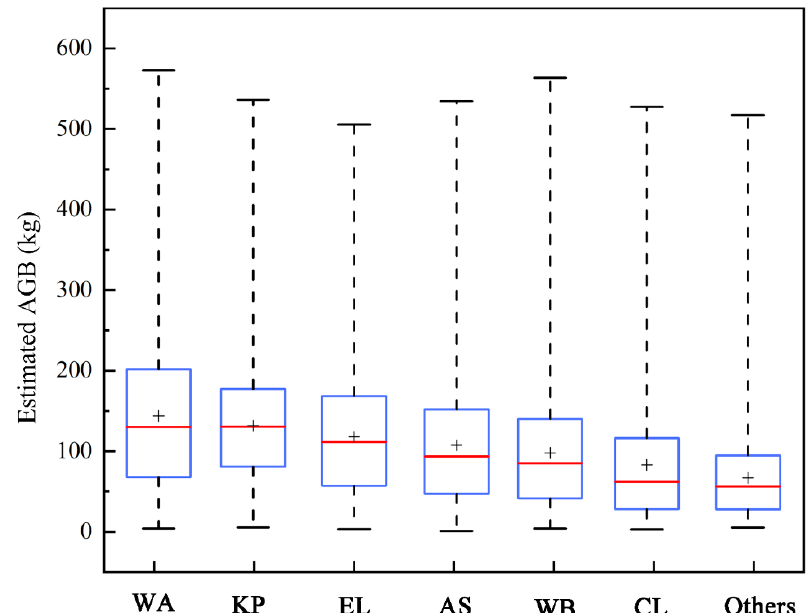
Figure 10. The AGB statistics at the individual tree level for each tree species in this study. The black “+” indicates the mean individual tree AGB of corresponding tree species. The red line indicates the median. The upper and lower box lines of the box plot represent the 75% and 25% quartiles, respectively. Note: KP— Korean pine ; CL— Changbai larch ; EL—elm; AS— Manchurian ash ; WB—white birch; WA— Manchurian walnut ; Others included any remaining tree species.